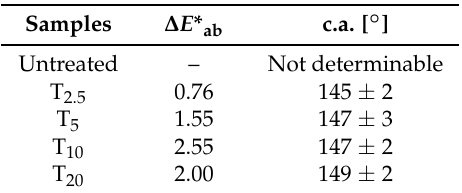
Table 2. Colour difference ( Δ E * ab ) and water ‐ stone static contact angle (c.a.), with the related maximum deviation, before and after the treatments.